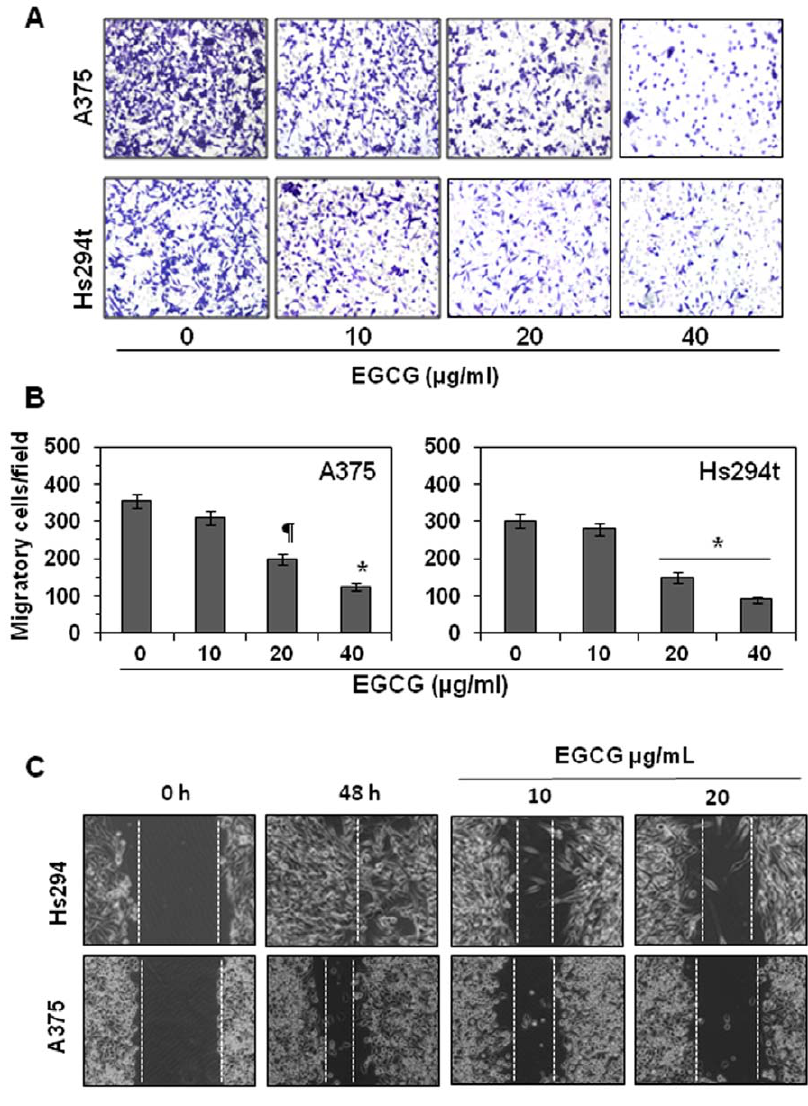
Figure 2. EGCG inhibits melanoma cell invasion/migration. ( A ) Treatment of human melanoma cells with EGCG for 24 h inhibits migration of A375 and Hs294t cells in a concentration-dependent manner. ( B ) The migrating cells were counted and the results expressed as the mean number of migratory cells 6 SD/microscopic field. Significant inhibition by EGCG versus non-EGCG-treated controls, " P , 0.01; * P , 0.001. ( C ) Scratch or wound healing assay was performed to assess the effect of EGCG on the migration of A375 and Hs294t melanoma cells. Incubation of A375 or Hs294t cells with EGCG (10 and 20 m g/mL) for 48 h inhibits migration of cells compared to non-EGCG-treated control cells. Assay was repeated three times and representative pictures are shown. Space between dotted lines in each panel shows the space without or negligent number of migrating